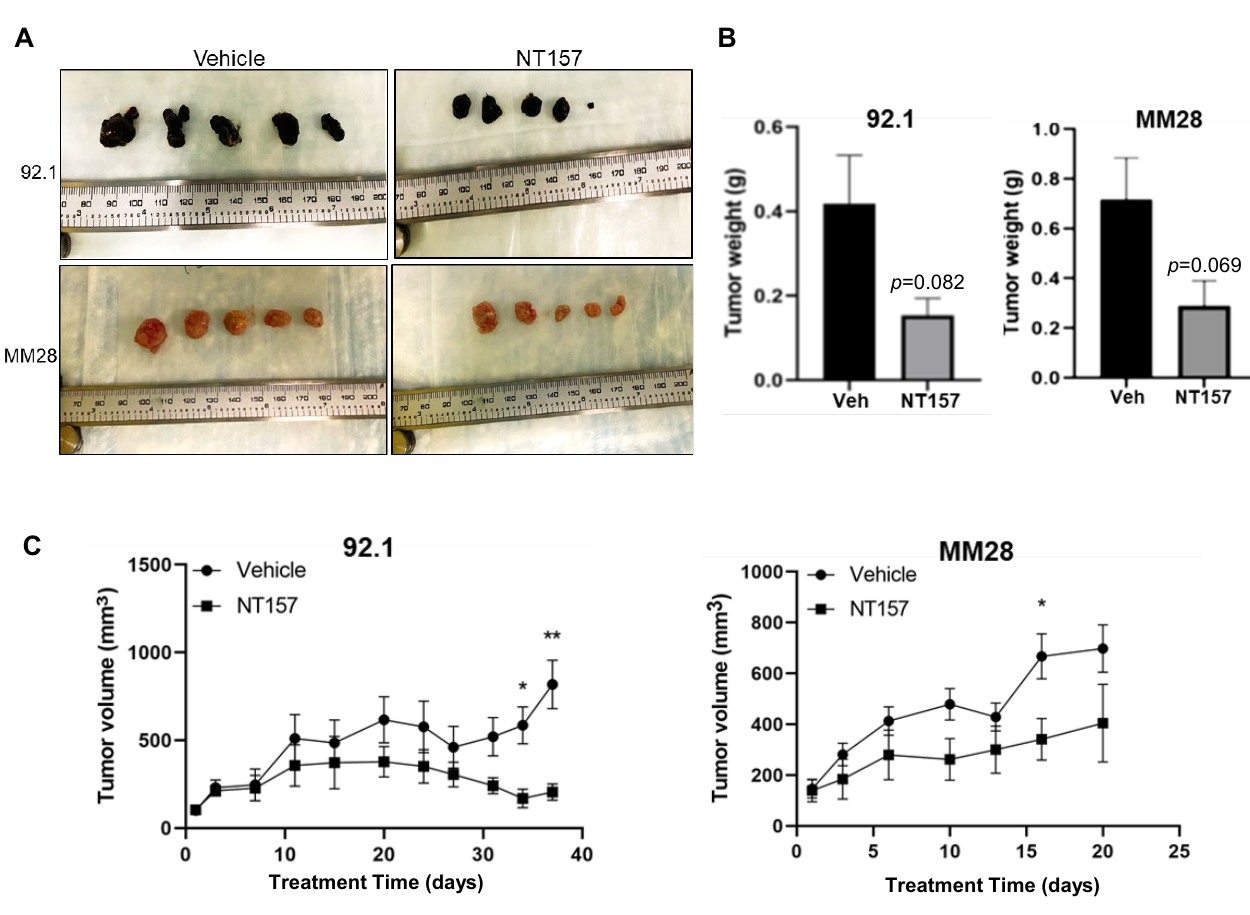
Figure 5. NT157 treatment inhibits UM tumor growth in a subQ mouse model . Subcutaneous tumors grown in NSG mice with 0.5 million UM cells 92.1 (top) and MM28 (bottom) were treated intraperitoneally with NT157 (50 mg/kg body weight), three times per week after tumors reached ~100 mm size. Tumor volume was measured twice weekly with slide calipers. When more than two tumors reached 1000 mm 3 volume in any one group, the experiment was ended, and tumors were harvested. ( A ) Shows harvested tumors from untreated and NT157-treated groups at the endpoint. ( B ) Shows a reduction in collective tumor weight at the endpoint and ( C ) A time-dependent reduction in tumor volume with NT157 treatment (1 µ M) vs. untreated controls. Student t -test was used for statistical analysis and the data points marked ** and * show p < 0.01 and <0.05,